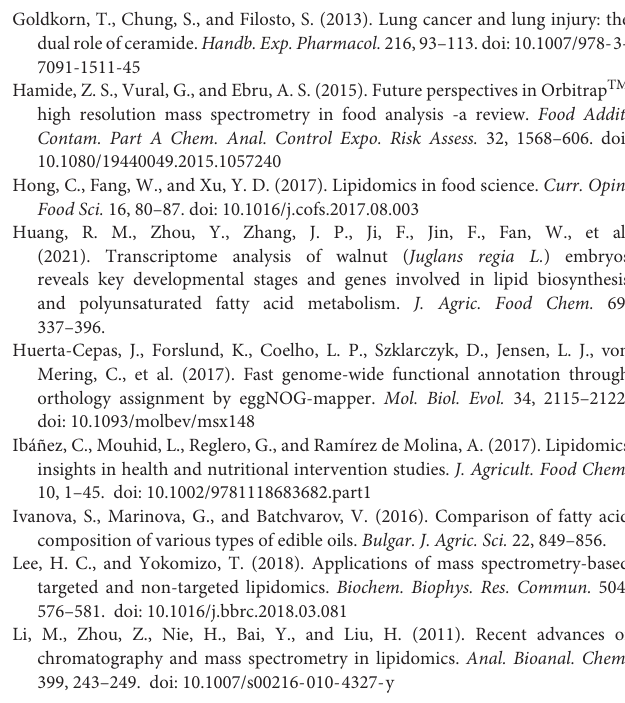
Supplementary Figure 1 | Chromatogram in ESI positive (A) and negative ion modes (B) of QX. Supplementary Figure 2 | (A) Secondary mass spectrometry of DG (18:2/18:2) (m/z 634.5405) generated fragmentation ion; (B) bubble chart, bubble in figure present significant difference of lipid molecules, different colors present different lipid subclasses. Supplementary Figure 3 | (A) Score and loading plots generated from PLS-DA classifying the lipid of QX and XE. (B) The content of different numbers of carbon in TGs of two walnut varieties. Supplementary Table 1 | Model evaluation parameters: R 2 X means the explanatory rate for the model of variable X; R 2 Y means the explanatory rate for the model of variable Y; Q 2 evaluates the predictive power of PLS-DA model. Supplementary Table 2 | The lipid molecules in lipid metabolism pathway of walnut kernel. QX ( µ g/g) and XE ( µ g/g) are the means four replicates ± standard deviation. Supplementary Table 3 | The enzymes involved in main lipid metabolism pathway of walnut kernel. FPKM means the genes of these enzymes expression level. ND means the genes were not